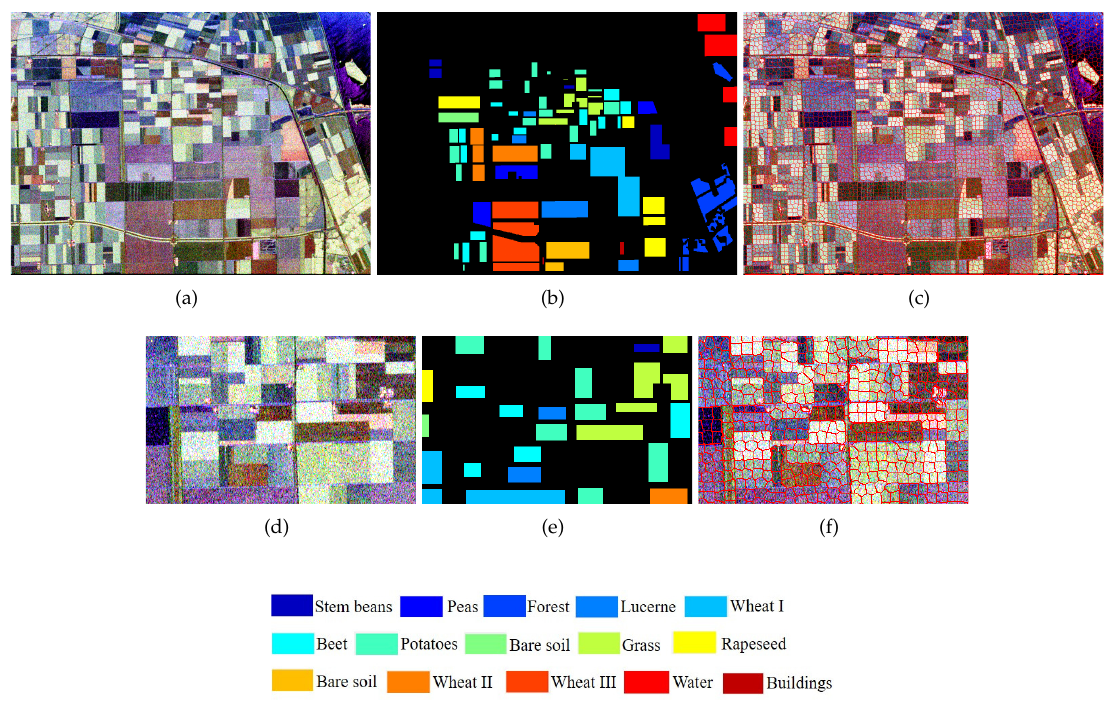
Figure 2. Display of the Flevoland data set. ( a ) the PauliRGB image, ( b ) the corresponding ground truth and ( c ) the segmentation results are for the complete Flevoland data set. ( d – f ) are the subset of the Flevoland data set with 200 × 320 pixels. ( d ) the PauliRGB image of the subset, ( e ) the corresponding ground truth of the subset and ( f ) the segmentation results of the subset.